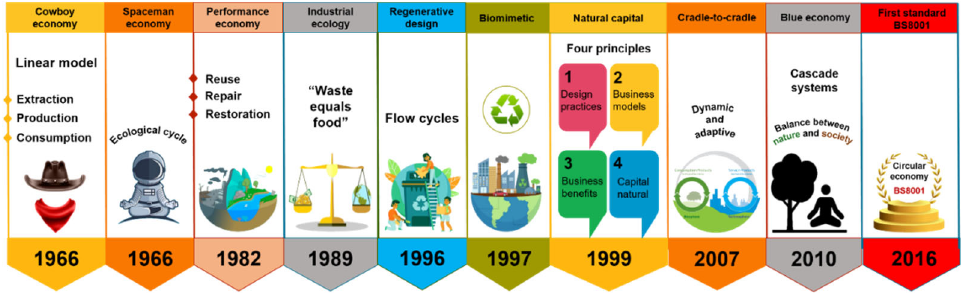
Figure 1. Circular economy concept development over time.